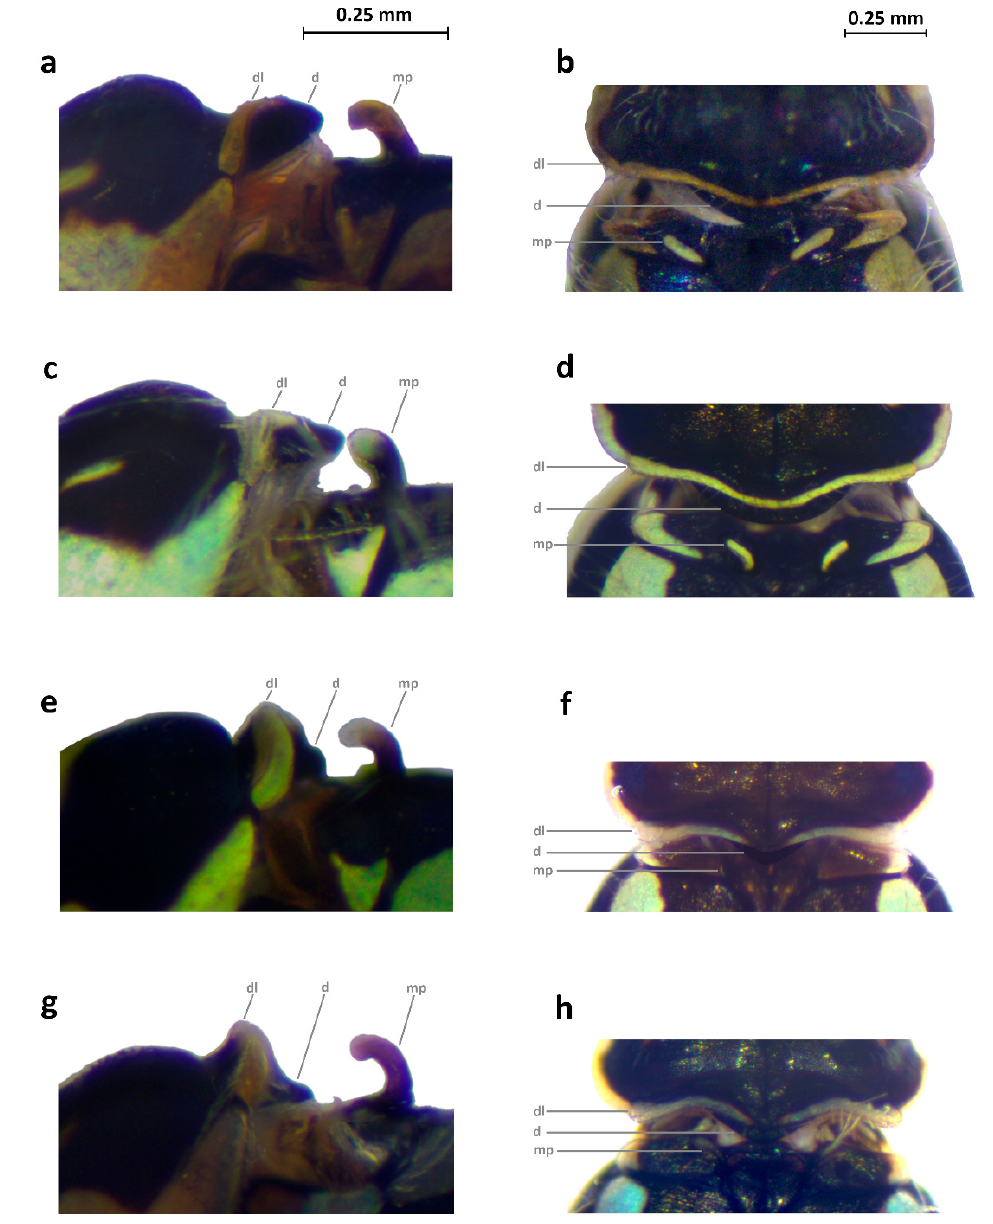
Figure 5. Posterior part of the pronotum and the anterior part of the mesothorax in males of Ischnura rubilio (lateral: ( a ), dorsal: ( b )) and Ischnura aurora from China (lateral: ( c ), dorsal: ( d )), Australia (lateral: ( e ), dorsal: ( f )), and Fiji (lateral: ( g ), dorsal: ( h )). dl : dorso-lateral elevation. d : dorsal expansion. mp : mesostigmal protuberance.